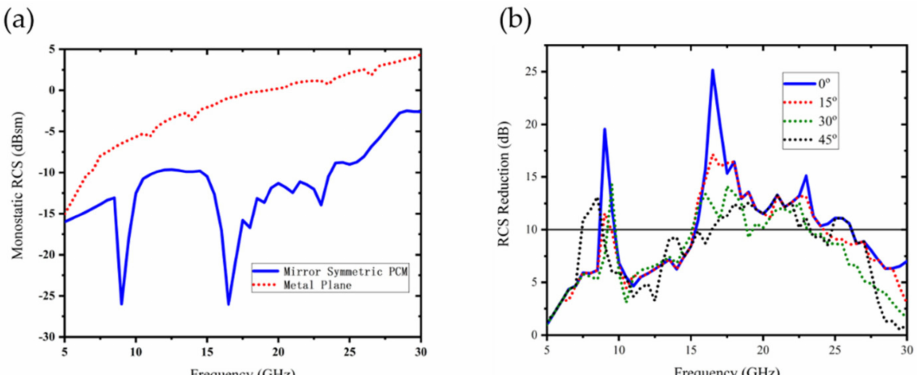
Figure 7. ( a ) Monostatic RCS. ( b ) RCS